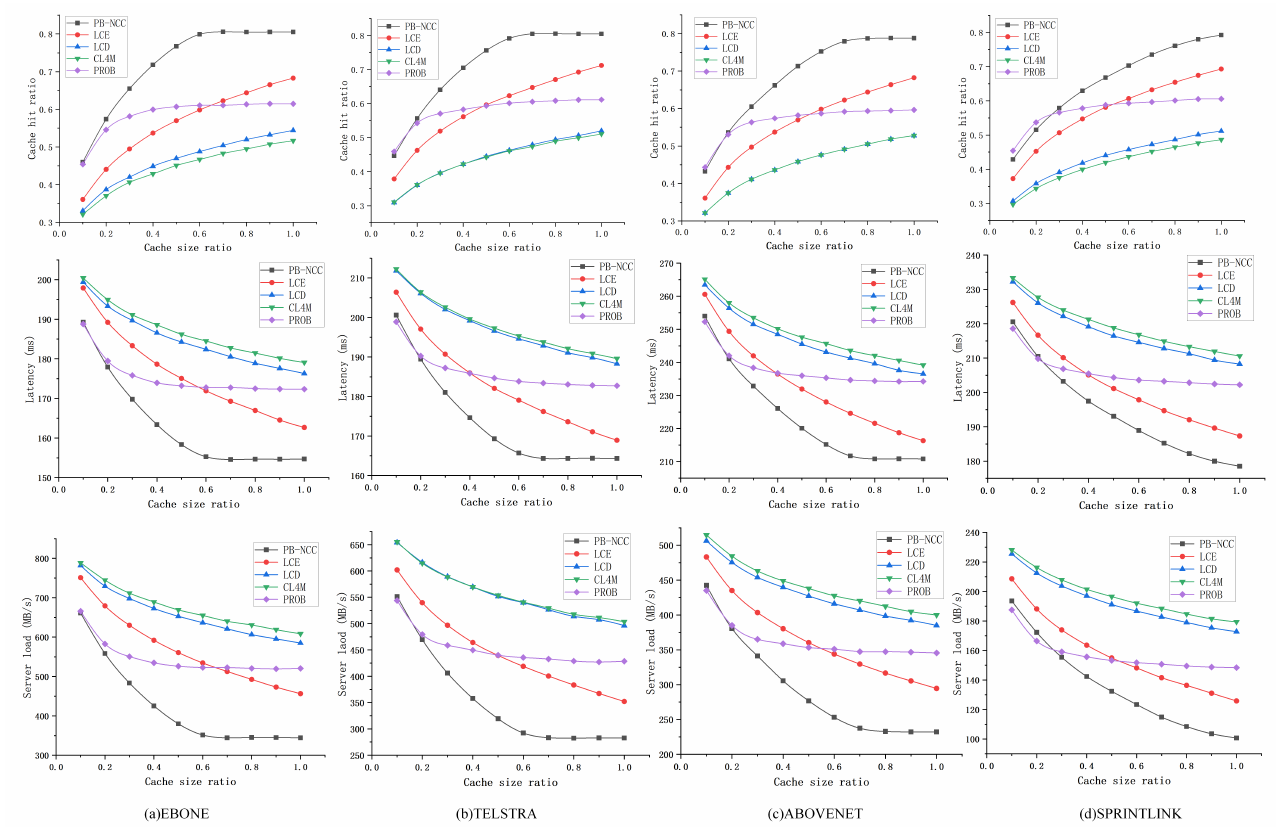
Figure 11. Comparison in ISP-like topologies when the cache size ratio changes. ( a ) performance in EBONE topology under a different cache size ratio; ( b ) performance in TELSTRA topology under a different cache size ratio; ( c ) performance in ABOVENET topology under a different cache size ratio; ( d ) performance in SPRINTLINK topology under a different cache size